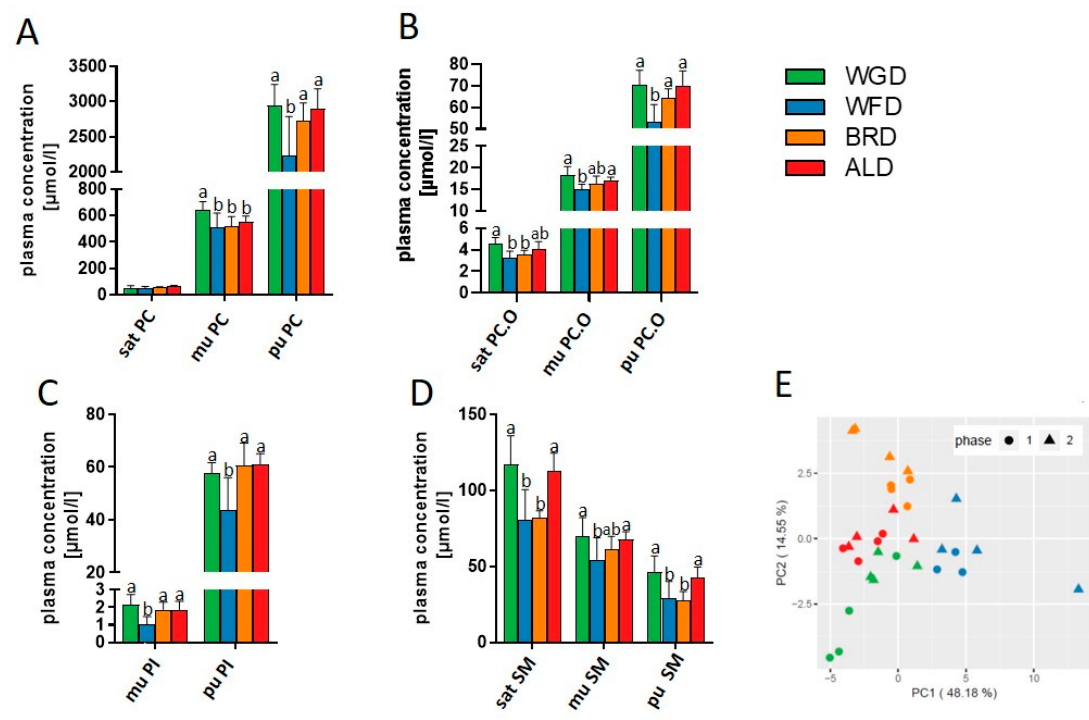
Figure 3. Plasma concentrations of several lipid classes, namely: Phosphatidylcholine (PC) ( A ), PC-ether (PCO) ( B ), phosphatidylinositol (PI) ( C ), and sphingomyelin (SM) ( D ), as well as the PCA results of lipidomics analyses ( E ). Data presented is mean ± SD; n = 7–8 / group. ALD: Aleurone supplemented diet; BRD: Bran supplemented diet; mu: Monounsaturated; pu: Polyunsaturated; sat: Saturated; WFD; White flour supplemented diet; WGD: Whole grain supplemented diet.